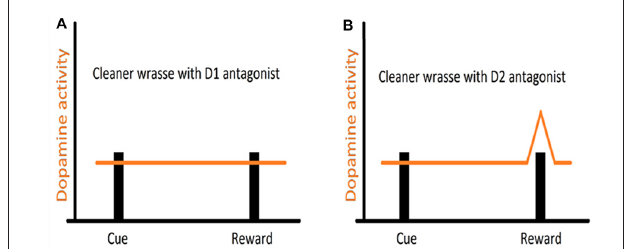
FIGURE 3 | Hypothesized representation of DA manipulation on reward signaling in cleaners: (A) DA transmission is disrupted by D1 antagonist administration, causing the DA signaling to fail, even when the reward is achieved, hence the continuous providing of tactile stimulation, even when cleaner wrasses have access to their client’s body surface (hypothetical reward); (B) with DA transmission impaired by D2 antagonist administration, the prediction signal that should fire upon cue display is disrupted and fails to occur. However, DA still signals the reward achieved and hence cleaners stop providing tactile